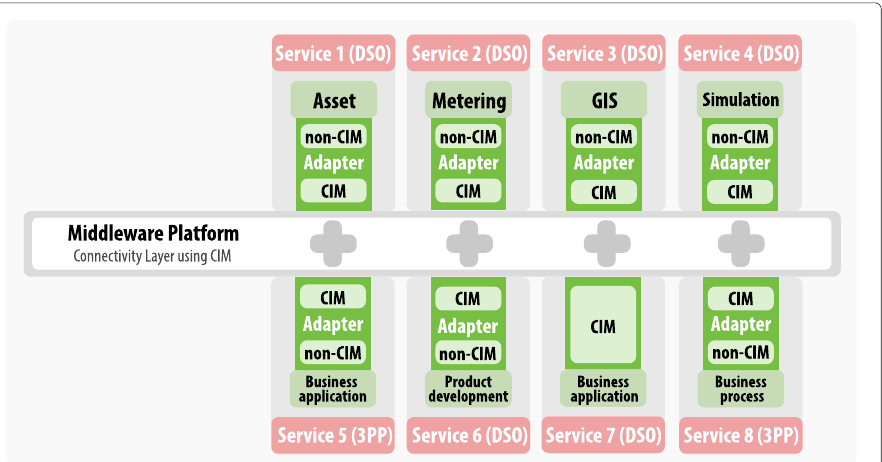
Fig. 4 Software architecture of the approach with exemplary